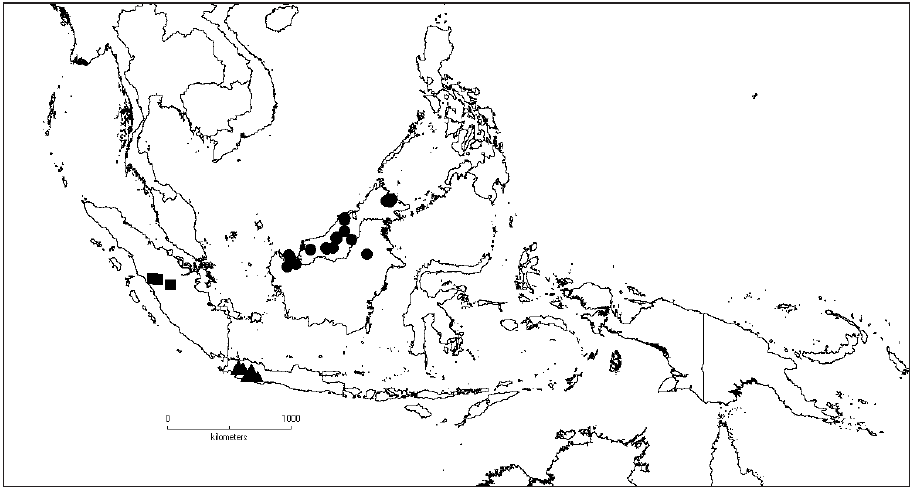
Map 17. Distribution of D. hirsutoidea ( ● ), D. horrida ( ■ ) and D. intermedia ( ▲ ).